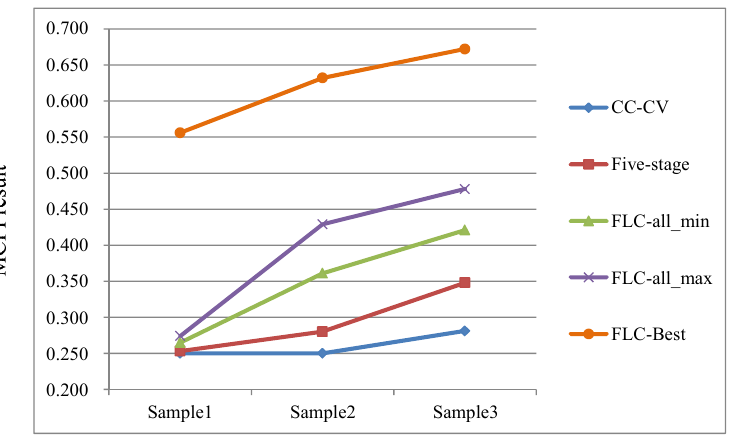
Figure 13. Obtained MCPI results of five tested algorithms.